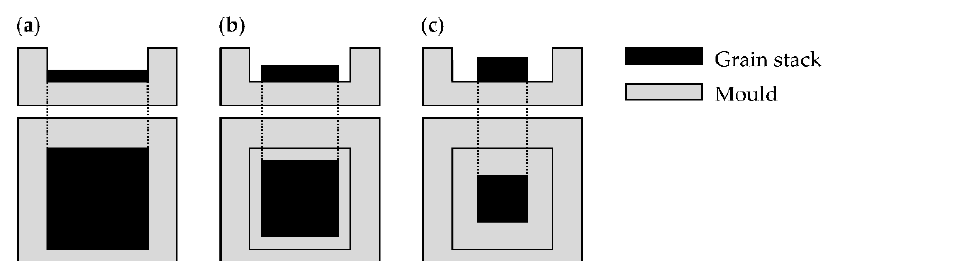
Figure 2. Illustration of mould coverage pattern and level ( a ) 100%, ( b ) 75% and ( c ) 50%. Once the mould is filled with grains, it is closed carefully and is subjected to a heat ramp of 5 ◦ C/min until a temperature of 200 ◦ C is reached. A temperature plateau at 200 ◦ C is then maintained for 15 min to have an isothermal condition in the mould cavity. After 10 min on the temperature plateau, a consolidation pressure (3 bars for QI panels and 50 bars for aggregate-reinforced panels) is applied for the rest of the thermo-